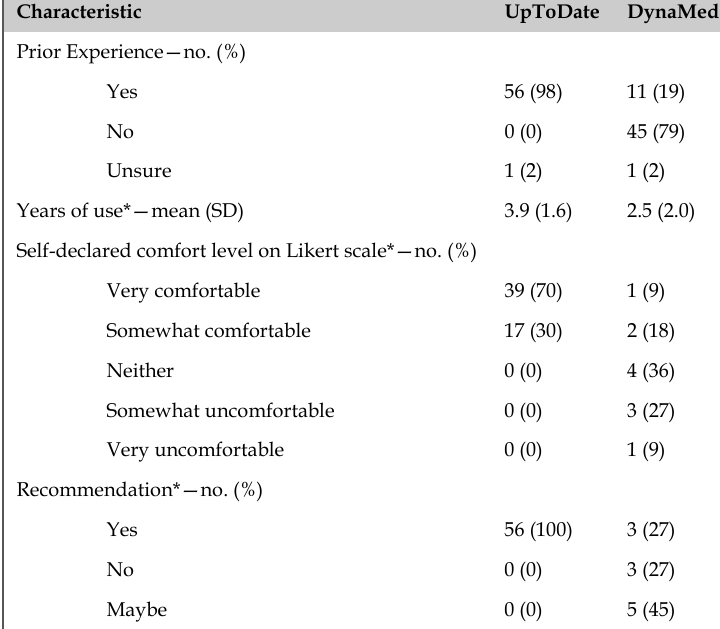
Years of use*—mean (SD) Self-declared comfort level on Likert scale*—no. (%) Very